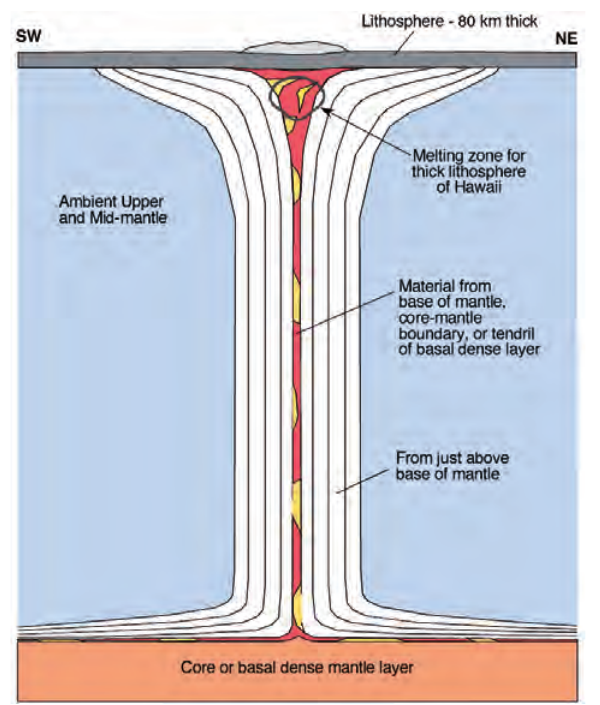
Figure 9. Schematic drawing showing the relationship between the central axis of a cylindrical mantle plume and the base of the mantle (from Bryce et al., 2005). The He and Nd isotopic ratio versus age data shown in Fig. 8 may represent a detailed vertical section through the lowermost 20–50 km of the mantle. In this interpretation, the high-3He signal is confined to the extreme base of the mantle and suggests that the 3 He signal may be associated with a basal, high-density mantle layer, or the outer core. The figure also depicts heterogeneities within the axial region of